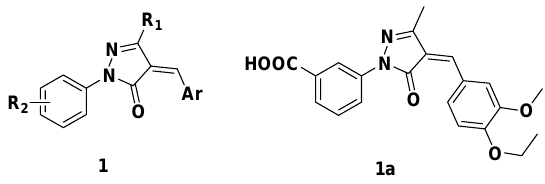
Figure 1. The structures of 4-arylidenepyrazolone derivatives 1 and FXR antagonist 1a